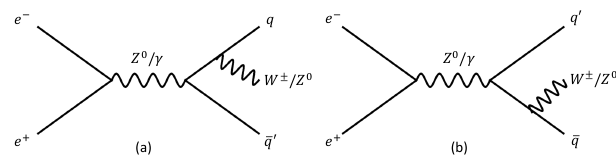
Figure 1. Fixed order equivalent channels for showering a e − e + → Z 0 /γ → q ¯ q process with a single-step q → q 0 V